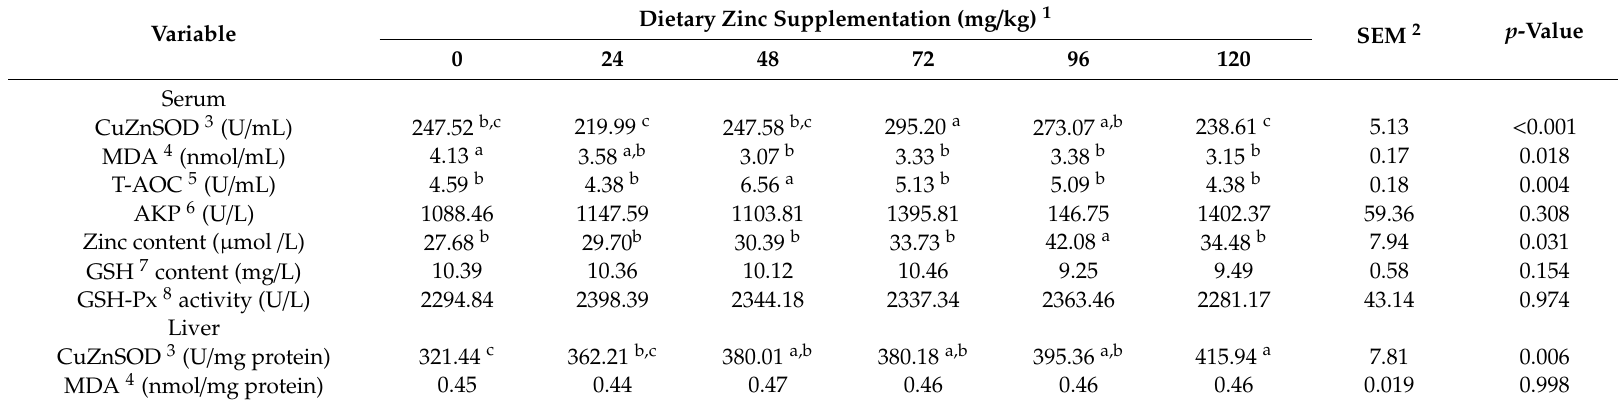
Table 7. E ff ects of dietary zinc supplementation on liver and serum biochemical indices of yellow-feathered broiler breeders aged 65 weeks.